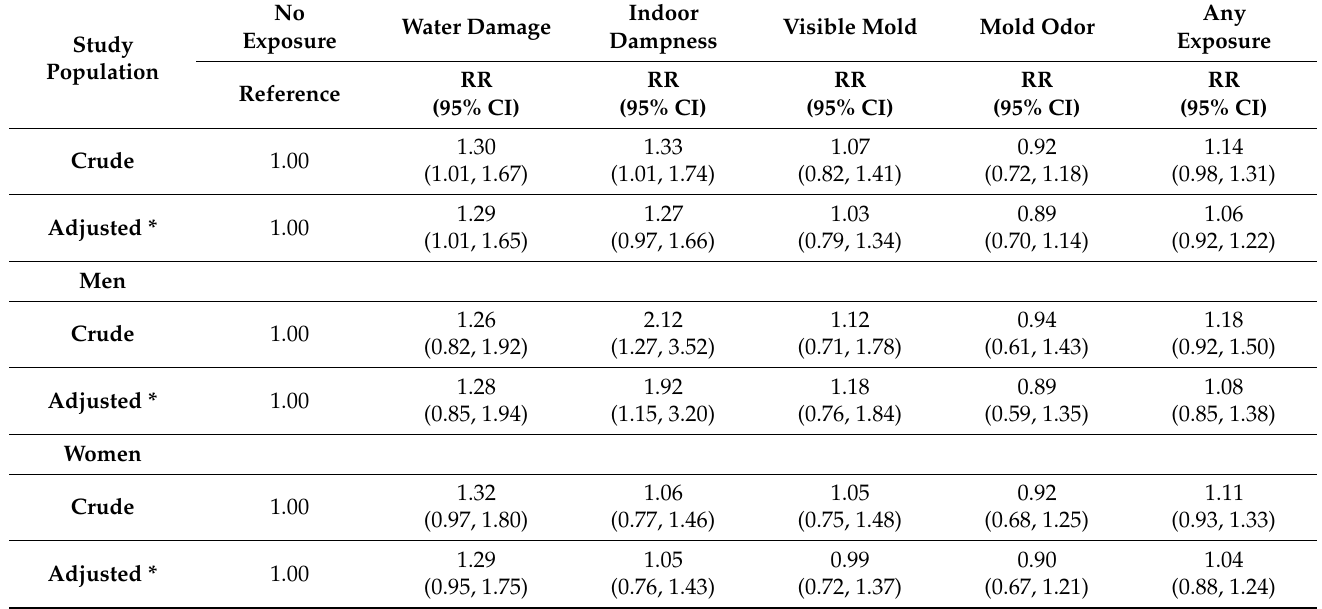
Table 3. Residential dampness and mold exposures and the risk of poor asthma control. Adjusted risk ratios (RRs) (95% confidence interval) contrasted between exposure categories and the reference category of no exposure from Poisson regression analysis. The Northern Finnish Asthma Study